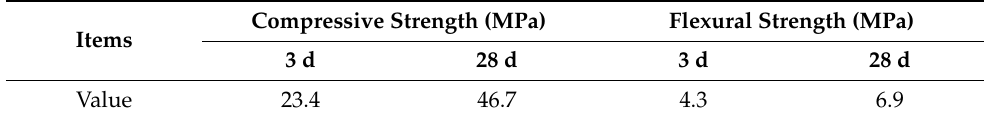
Table 3. The tested mechanical properties of P.O. 42.5R cement used in the study.